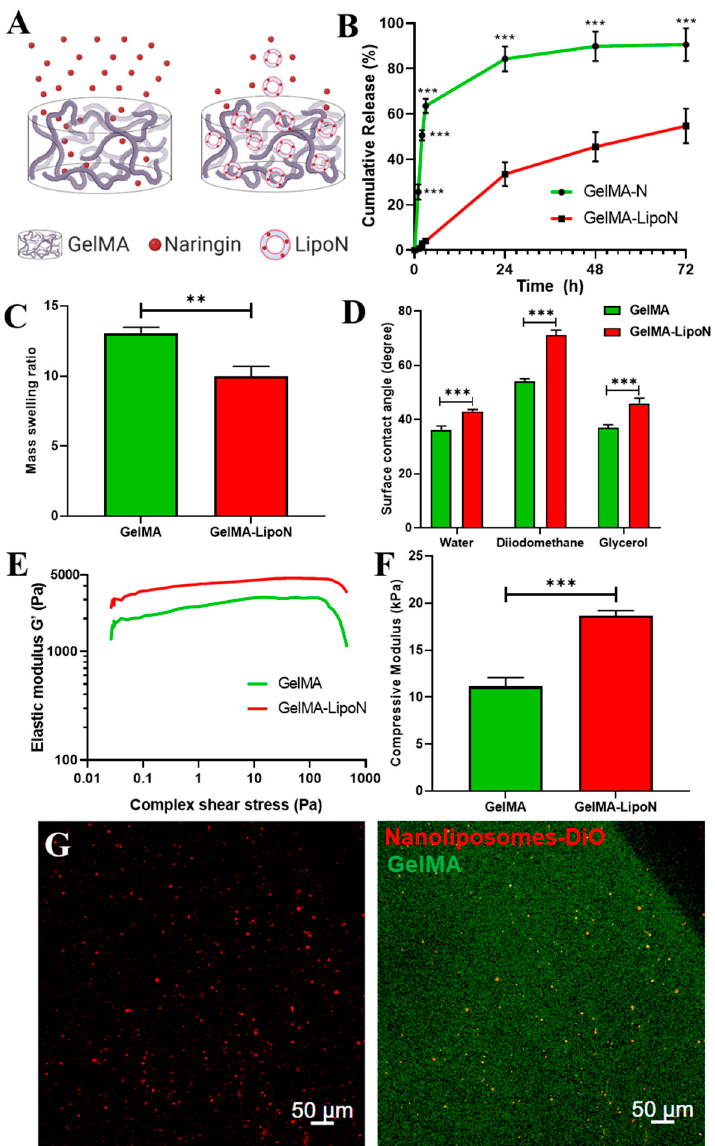
Figure 3. ( A ) Schematic representation of the different release behavior of naringin embedded directly in GelMA (GelMA-N) versus when first encapsulated in liposomes (GelMA-LipoN). Created with BioRender.com. ( B ) The in vitro cumulative release profile of GelMA-N and GelMA-LipoN in dPBS (pH = 7.4) at 37 °C. ( C ) The mass swelling ratios of GelMA and GelMA GelMA-LipoN hydrogels. ( D ) The surface contact angle of GelMA and GelMA-LipoN hydrogels measured using water, diiodomethane, and glycerol. ( E ) The elastic modulus (G’) as a function of complex shear stress and ( F ) the compressive modulus of GelMA and GelMA-LipoN hydrogels. ( G ) Confocal micrographs of DiO-loaded nanoliposomes embedded in a bioprinted 3D GelMA construct. Red channel: nanoliposomes-DiO. Green Channel: GelMA autofluorescence. Data are represented as mean ± s.d., n = 3. The reported data of ( C , F ) were analyzed using a Student’s t -test and of ( B , D ) using a two-way ANOVA followed by Holm-Sidak’s test. Significance was indicated as **( p < 0.01) and ***( p < 0.001).